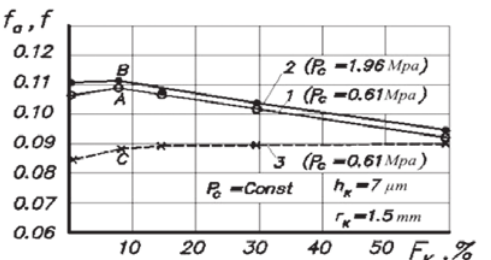
Fig. 3. Dependence of the adhesion component of the friction factor f а (curves 1, 2) and the friction factor f after the micro running-in (curve 3) on contour pressure р С for surfaces without micro grooves